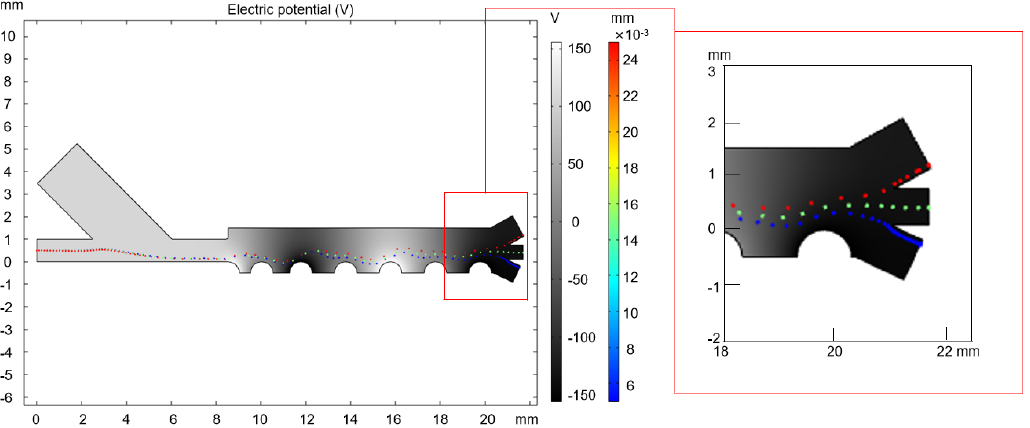
Figure A9. Separation of polystyrene samples based on dimensions (5 µm,15 µm,25 µm): U 0 = 156 V eff , f = 100 kHz, 𝜎 (cid:3040) = 8 × 10 − 4 S/m, 𝑢 (cid:2869) = 2 mm/s 𝑢 (cid:2870) = 1 mm/s.